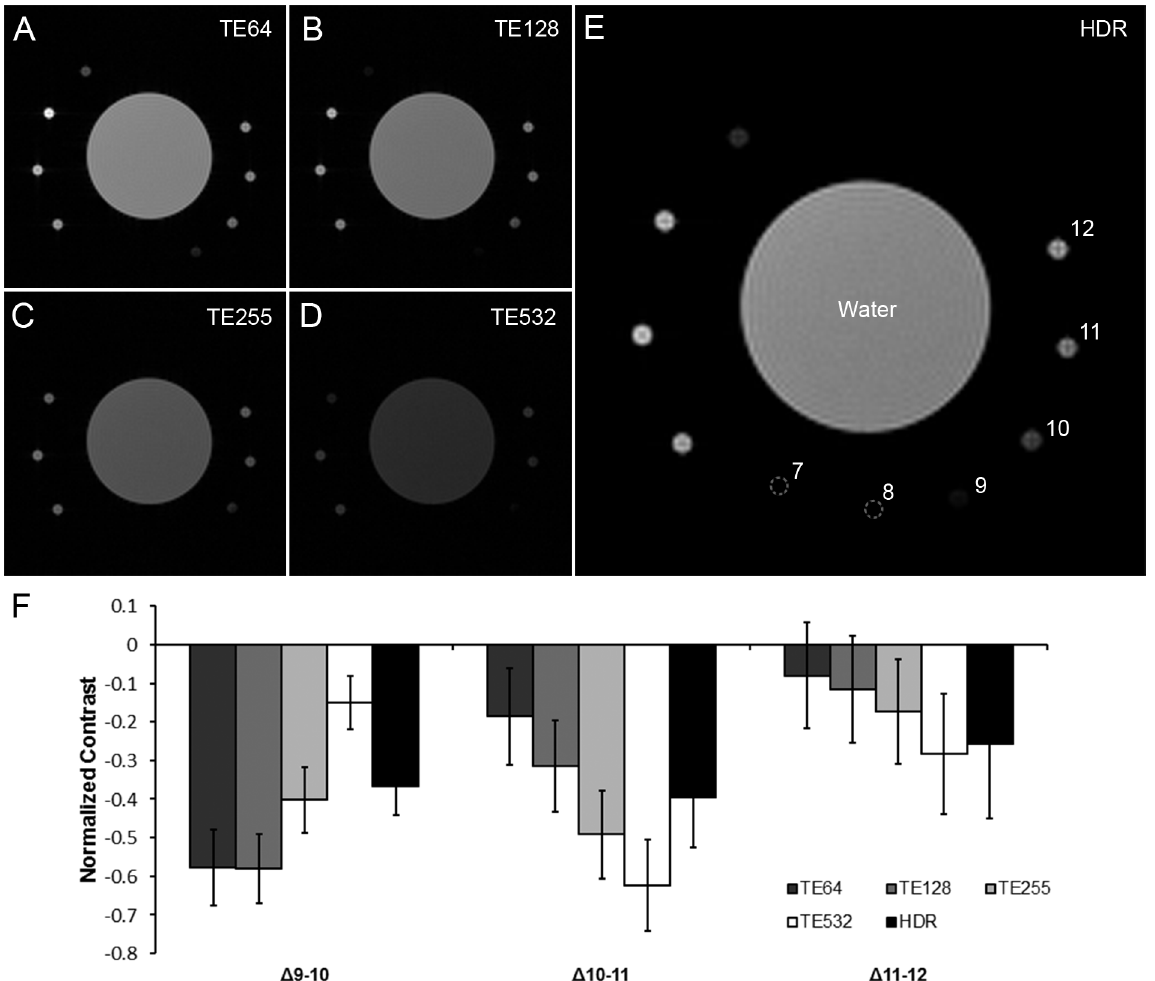
Figure 5. T 2 -weighted HDR-MRI. A series of images were acquired with constant T R at 4000 ms and T E at (A) 63.81 ms (B) 127.62 ms (C) 255.24 ms and (D) 531.75 ms. Images A–D were computationally merged by the HDR algorithm to generate the (E) HDR image. HDR-MRI accurately captured the intensity difference between samples 9, 10, 11, and 12, which was not achieved in any of the source images. This was shown quantitatively by contrasts normalized against water (F). Image A was poor at differentiating samples 10–12, B and C were poor at differentiating samples 11 and 12, and D was poor at differentiating samples 9 and 10. Error bars represent standard deviation.